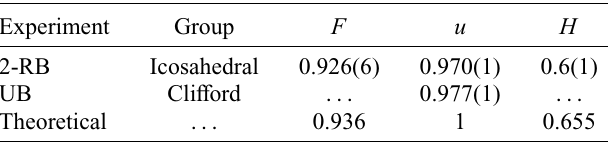
TABLE III. The estimated values of the fidelity, unitarity, and self-adjointness from the experiment of the 2-RB and that of the UB in the superconducting qubit